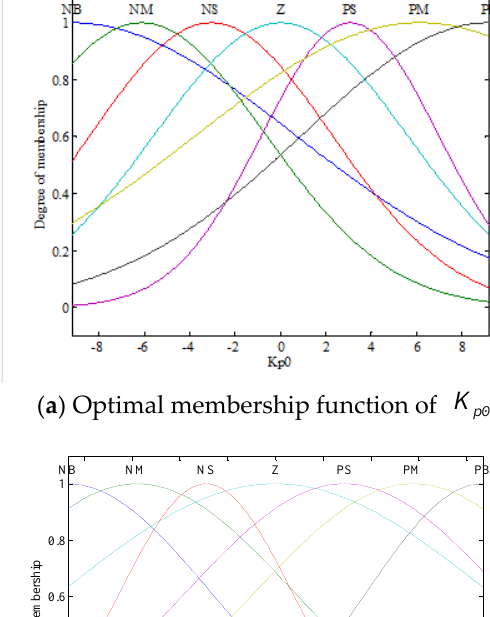
Figure 9. Pareto optimal solutions obtained through MOGSA for speed disturbance of +0.01 and −0.01 under 526 m low water head.